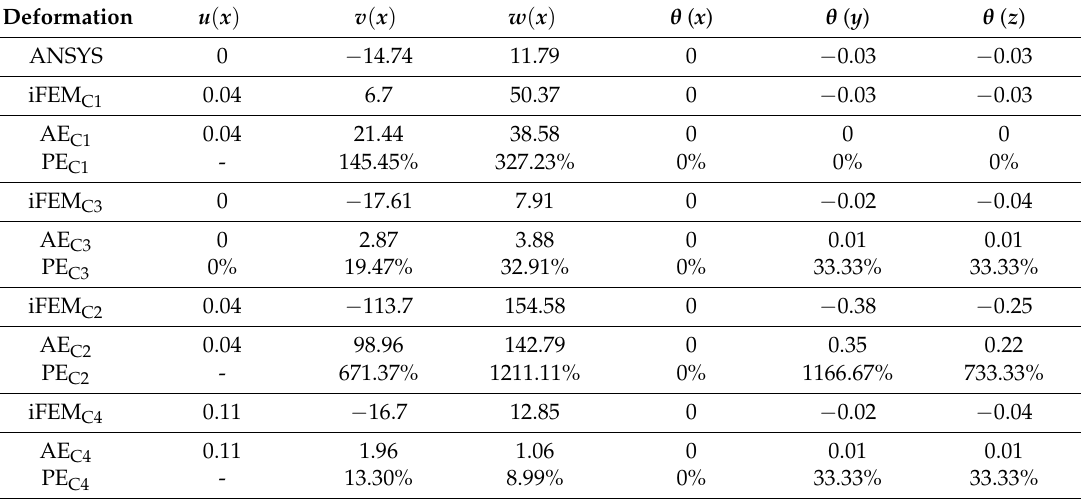
Table 5. Comparisons among deformations computed with iFEM and deformations extracted from ANSYS in case of end-node loads (Loading A). Strain inputs contained errors.